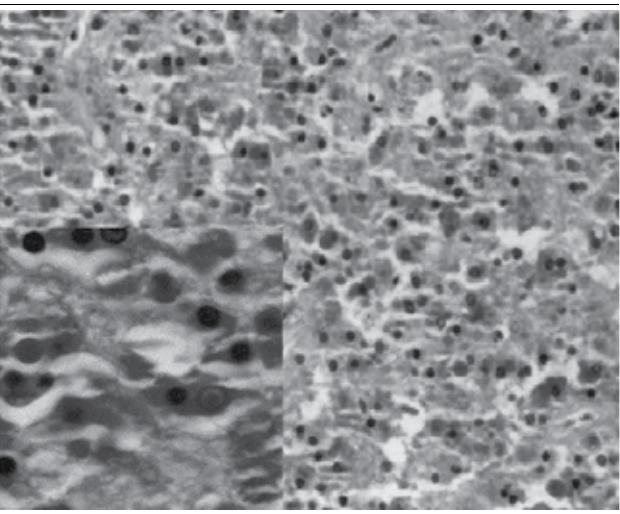
figurE 4 – Lung lesions consisted of mononuclear cells proliferation, mainly at the expenses of histiocytes, plasmocytes, and lymphocytes, with fibroblast proliferantion got in the way (PAS,